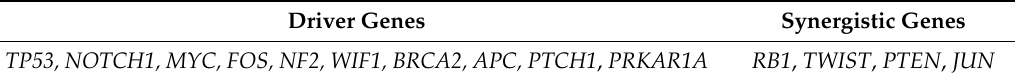
Table 3. Driver (strong inductors) and synergistic genes (need “a cooperation” with driver genes) in which alterations may lead to osteosarcoma [89,90,92,93].